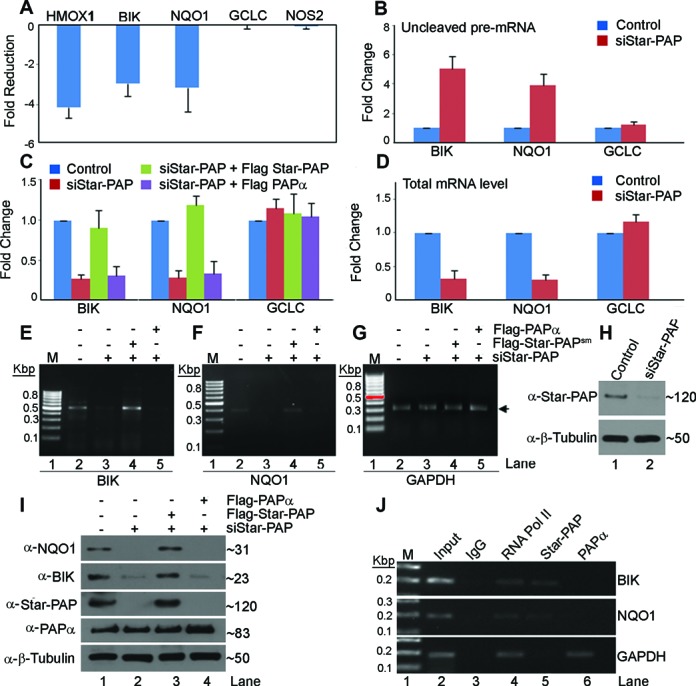
Star-PAP controls distinct mRNA target independent of PAPα. (A) qRT-PCR analysis of mRNAs after knockdown of Star-PAP in HEK 293 cells expressed as fold-reductions relative to the control cells. (B) Measurement of uncleaved pre-mRNA of BIK, NQO1 and GCLC by qRT-PCR expressed relative to total mRNA level in presence and absence of Star-PAP knockdown. Total mRNA levels are shown in D. (C) qRT-PCR analysis of the expression of BIK and NQO1 mRNA level after Star-PAP knockdown followed by rescue with stable expressed FLAG-Star-PAP insensitive to the siRNA used for the knockdown or stable expressed FLAG-PAPα in HEK 293 cells. (D) Total mRNA levels of corresponding genes in B. (E–G) 3′-RACE assay of BIK, NQO1 and GAPDH under the similar conditions as in C. (H) Western blot showing knockdown of Star-PAP. (I) Western blot of NQO1, BIK and control β-Tubulin from HEK 293 cell lysates after knockdown of Star-PAP and rescue with FLAG-Star-PAP or -PAPα as described in C. Wherever (–) siRNA is indicated, we have used control scrambled siRNA. (J) RNA immunoprecipitation analysis of RNA Pol II, Star-PAP and PAPα on UTR RNAs as indicated.